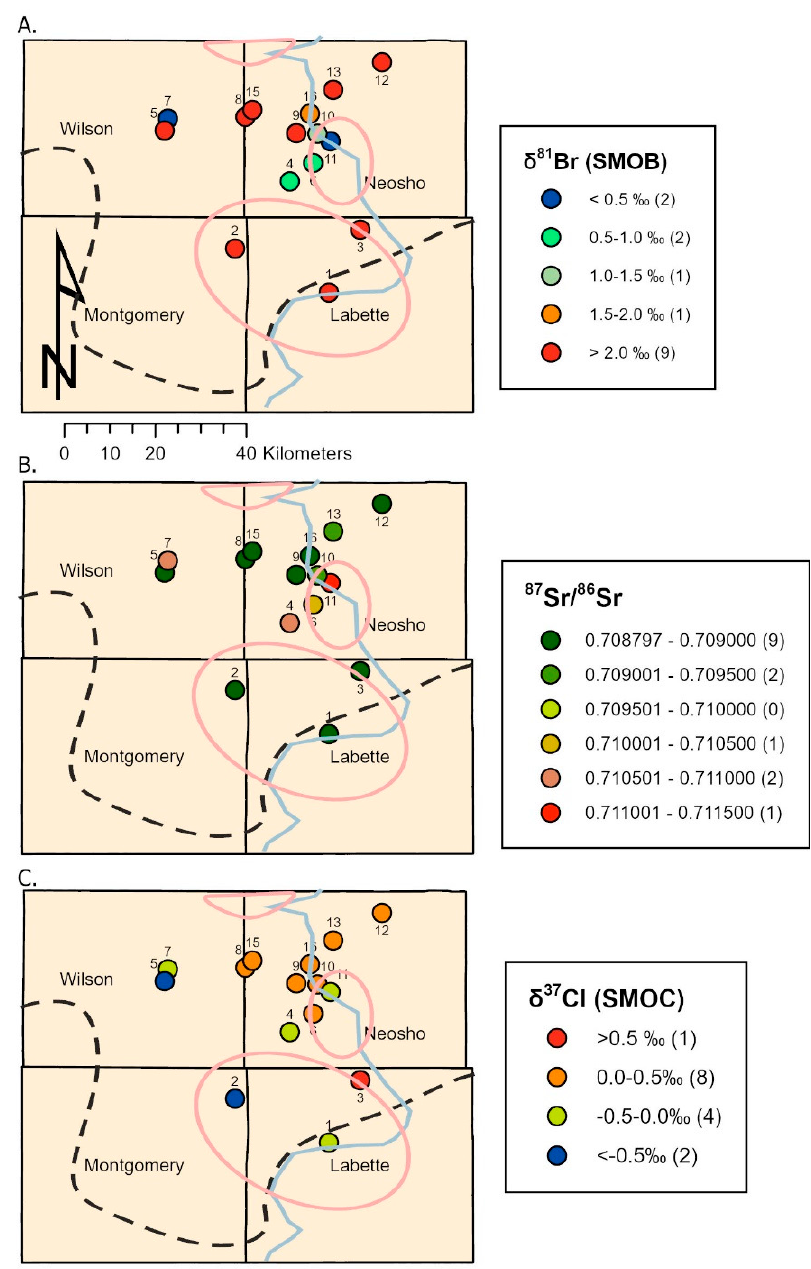
Figure 5. Spatial relationship of δ 81 Br ( A ), 87 Sr/ 86 Sr ( B ), and δ 37 Cl ( C ) for 2013 samples. Three of the wells in Group “B” (see Table S3 and discussion in text), which includes 4, 6, 7, and 11, are located in southwest Neosho County. Galesburg geothermal anomaly [46]. Circled areas indicate the locations of geothermal anomalies identified by Newell [46]. The solid grey line identifies location of the 10,000 ppm TDS contour in the Arbuckle Gp. [56], while the dashed black line identifies the approximate boundary where the underlying Arbuckle Gp. has a higher salinity than the overlying Mississippian. In the deeper Arbuckle Gp. Well 2 is representative of the new end-member proposed in this work. In the deeper Arbuckle Gp., salinity is higher to the west of the grey line, and is higher than in the Mississippian to the south of the dashed